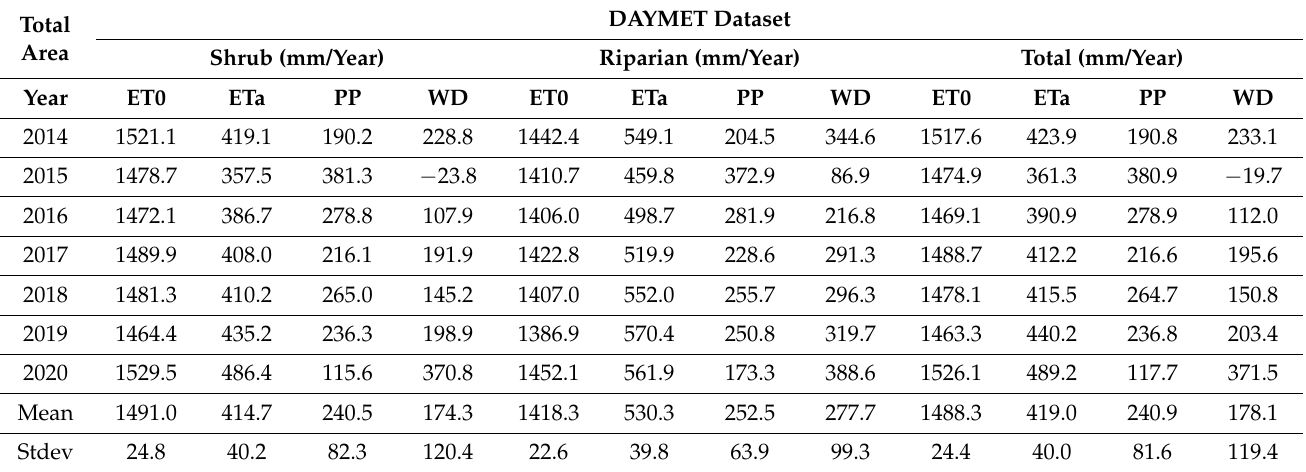
Table 5. Water metrics (ETo, ETa, PP, WD) using Daymet gridded weather data (1 km) and Landsat for each year, their mean and standard deviation, calculated for the riparian ROI by ground area for shrubs, trees, and total riparian vegetation for the full study area within the Navajo